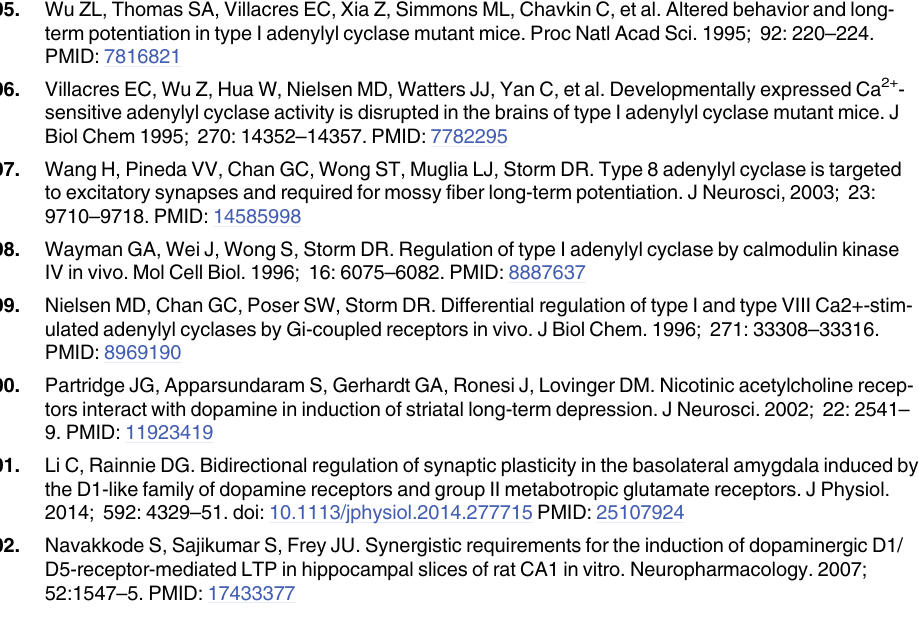
PLOS ONE | DOI:10.1371/journal.pone.0131948 July 2,